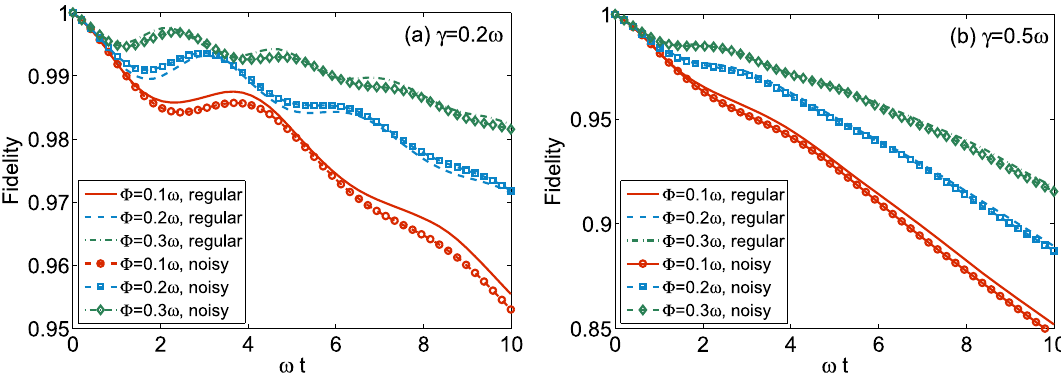
Figure 1. Fidelity dynamics of a 10-level atomic system under control of regular and noisy pulse sequences. The n − 1 a j | j � is such chosen as | a j | 2 = 1 / 10 . The parameters are chosen as κ j = 0.1 ω , E j = 0 = 0 target state | A � = j = 0 and E 0 ( t ) = ω . For regular rectangular pulse, | c ( t ) | = �/� for m τ − � ≤ t ≤ m τ , where m ≥ 1 is an integer; (cid:31) otherwise, | c ( t ) | = 0 . (cid:31) , (cid:31) , and τ are the strength, duration and period of pulse, respectively. Here τ = 0.02 ω